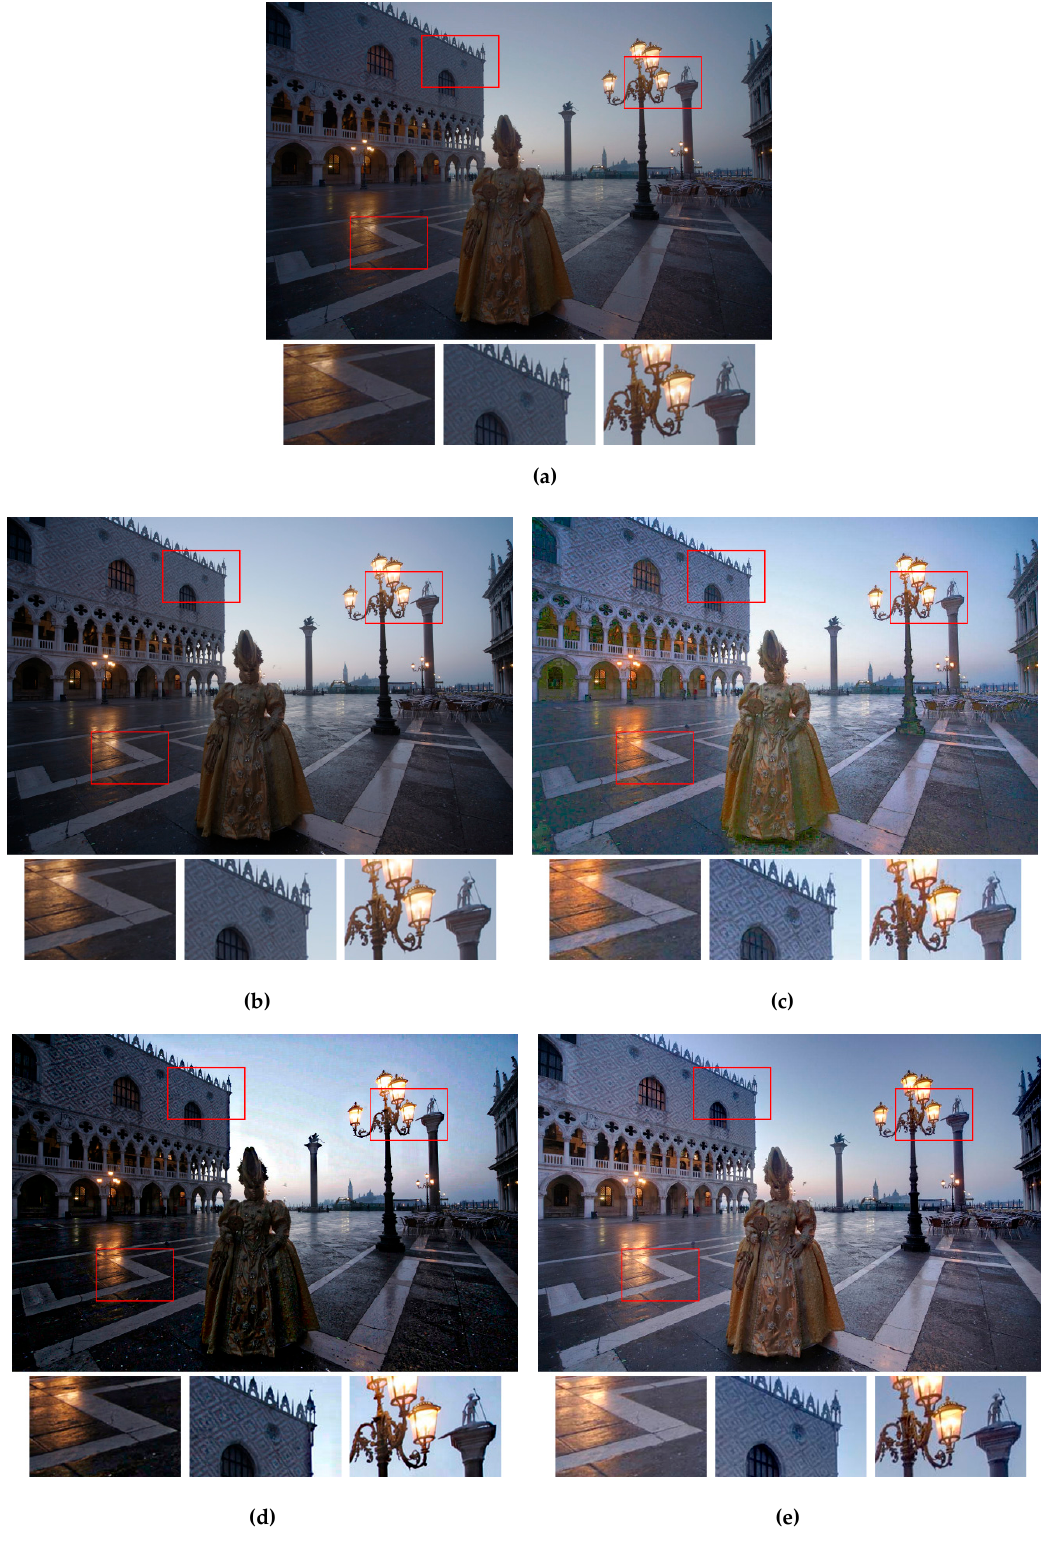
Figure 6. Visual comparison of the exposure fusion results using the test image Masked Lady . ( a ) Results from the method in Reference [5]. ( b ) Results from the method in Reference [6]. ( c ) Results from the method in Reference [28]. ( d ) Results from the method in Reference [23]. ( e ) Results from the proposed method. The enlarged versions of the red rectangles are provided to illustrate the subtle differences.